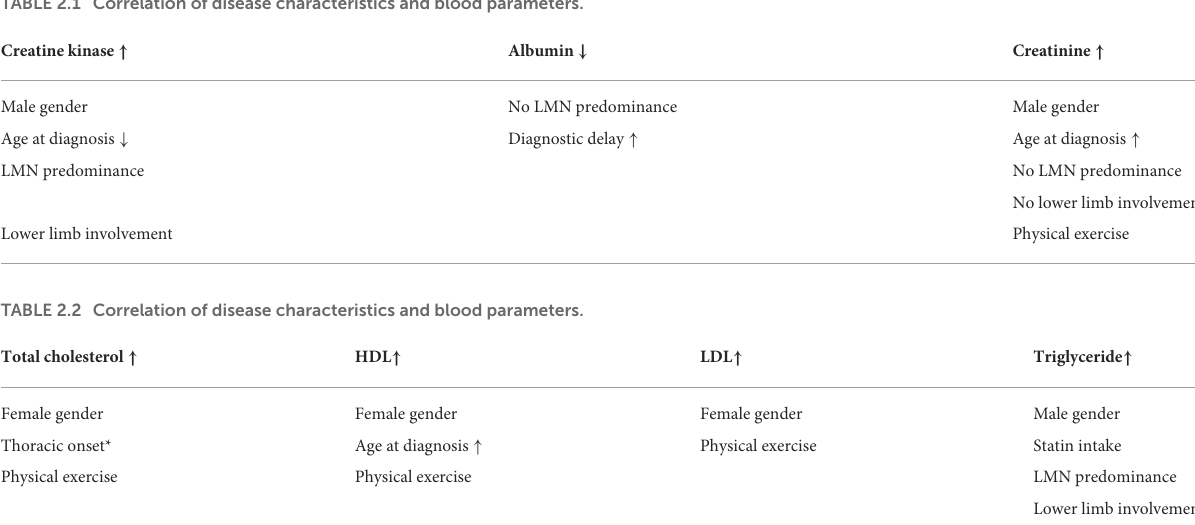
TABLE 2.1 Correlation of disease characteristics and blood parameters.